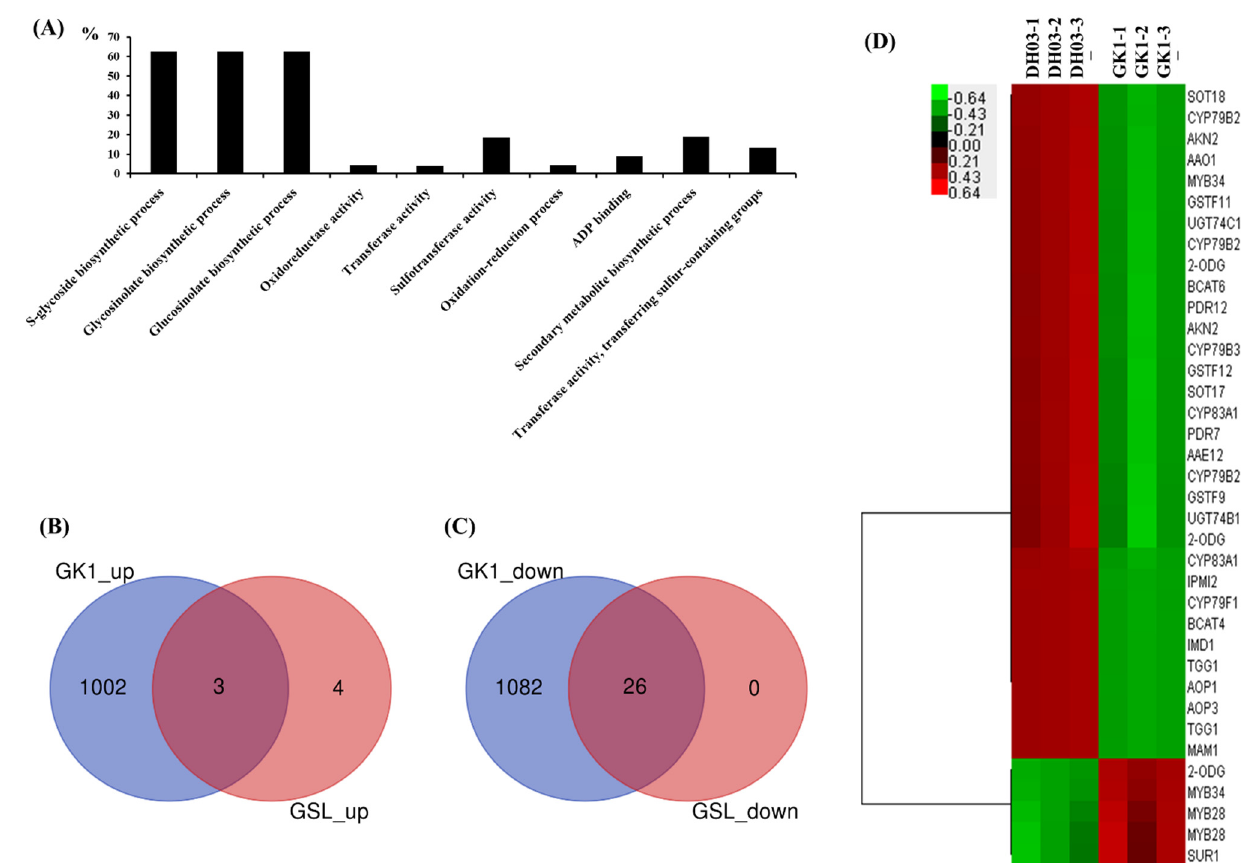
Figure 4. Expression of GSL pathway-related genes. GO term enrichment analysis indicates that GSL-related categories were the most significantly downregulated DEGs in GK1 (red bars). ShinyGO (v. 0.61) was employed for GO analysis (http://bioinformatics.sdstate.edu/go/, accessed on 20 August 2021). The percentage (%) on the y -axis is calculated as follows: % = (number of genes in DEG list ÷ total corresponding pathway genes) × 100 ( A ). Venn diagram showing GSL pathway genes among 930 DEGs upregulated ≥ 2-fold ( B ) and 1028 DEGs downregulated ≥ 2-fold in GK1 ( C ). Heatmap of GSL pathway genes among DEGs between DH03 and GK1 ( D ).